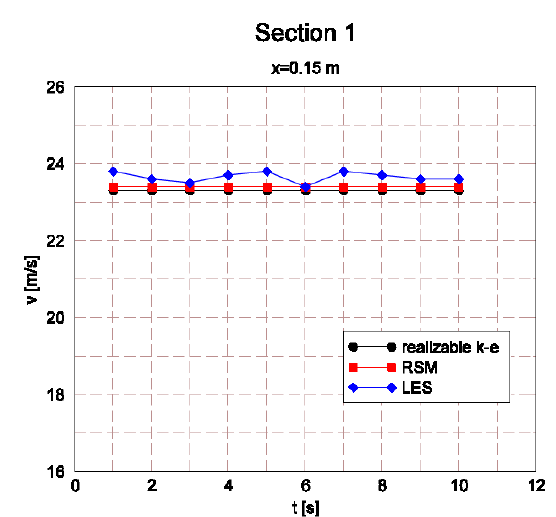
Figure 4. Velocity evolution in time for section 1 for the three turbu- lence models.